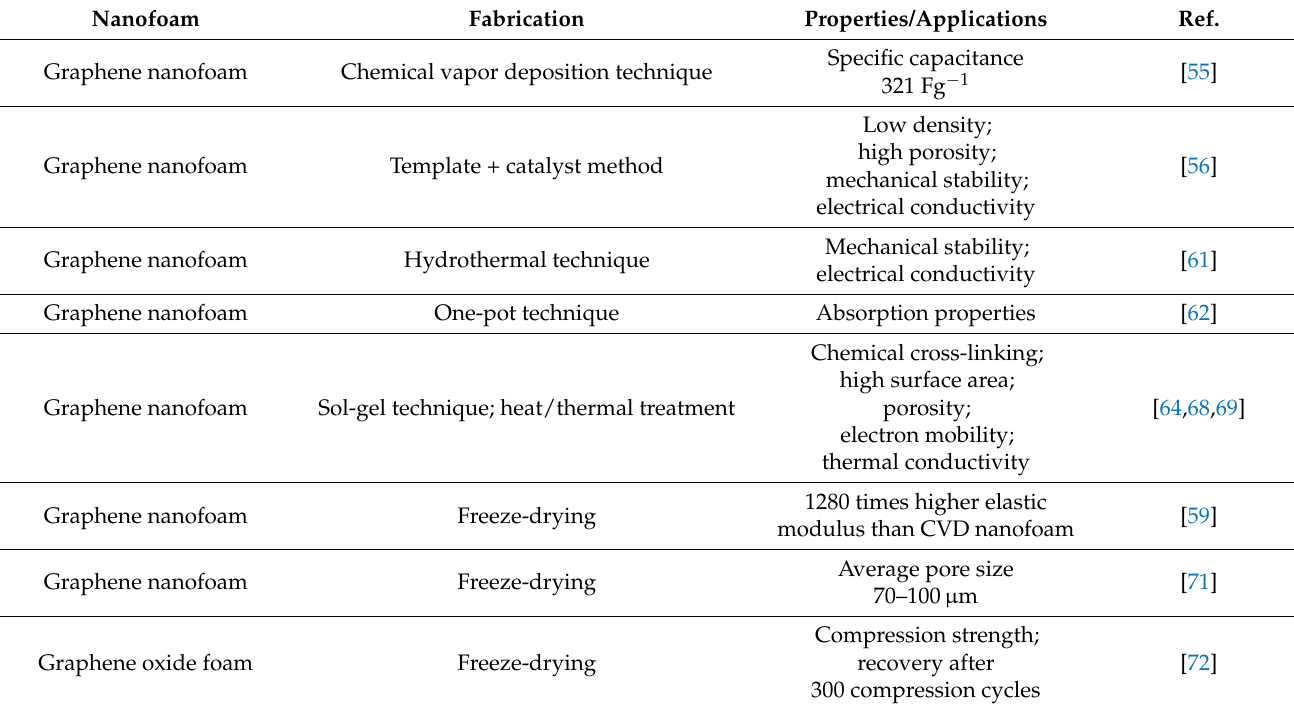
Table 1. Essential properties of graphene